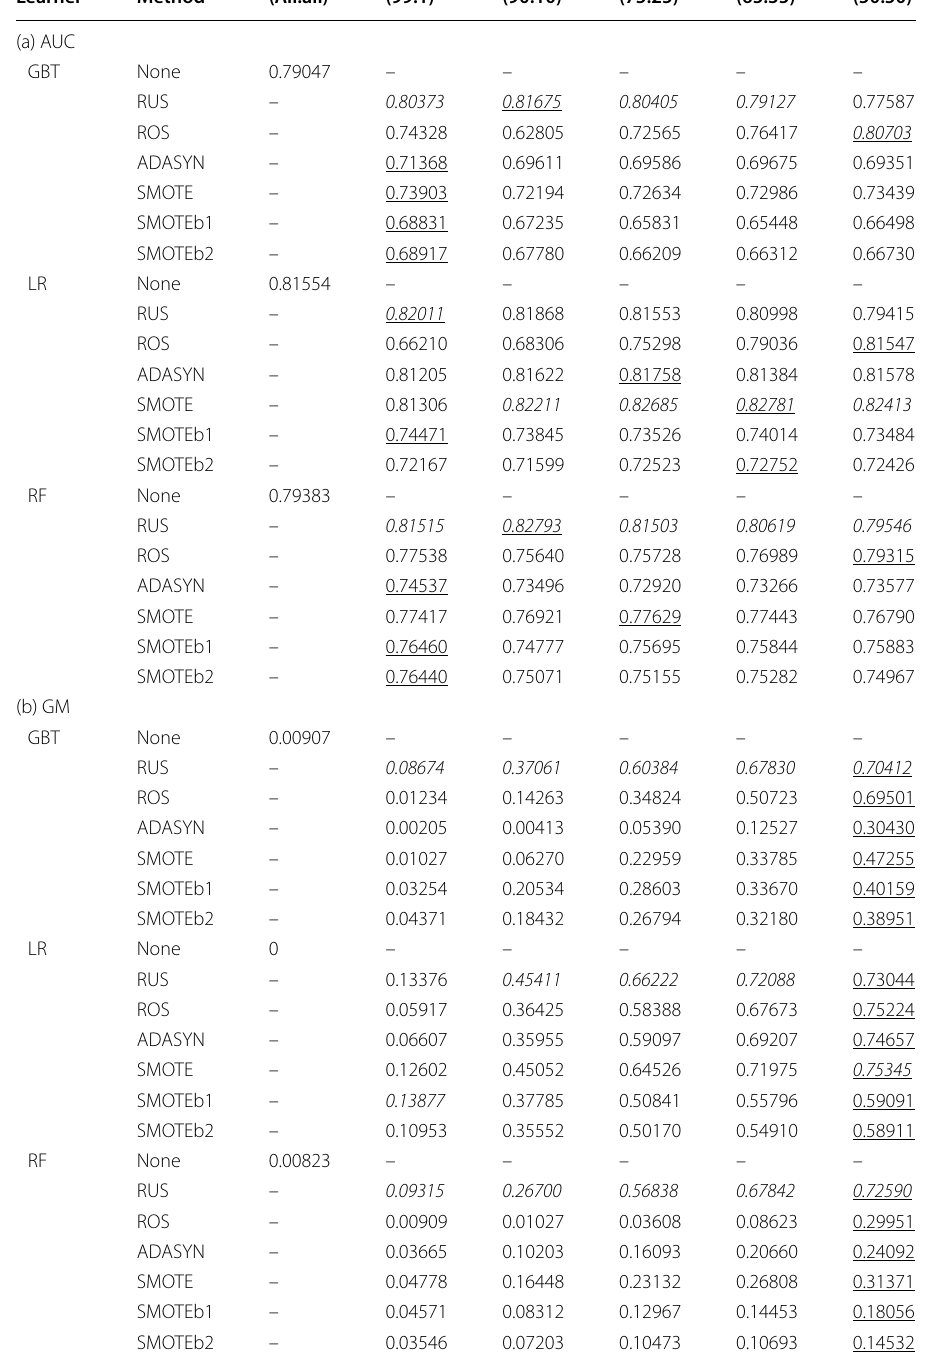
The highest value within each column (class distribution ratio) of each sub-table is in italic type, and the highest value within each row (sampling method) of each sub-table is underlined